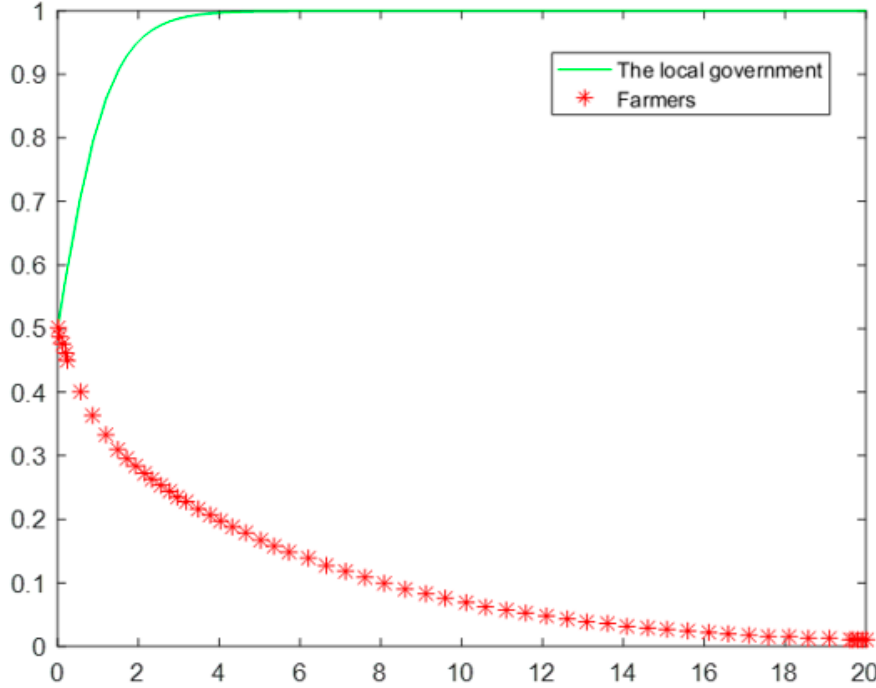
Figure 5. Evolution of strategic choices for local governments and farmers under potential conflict situations (2).